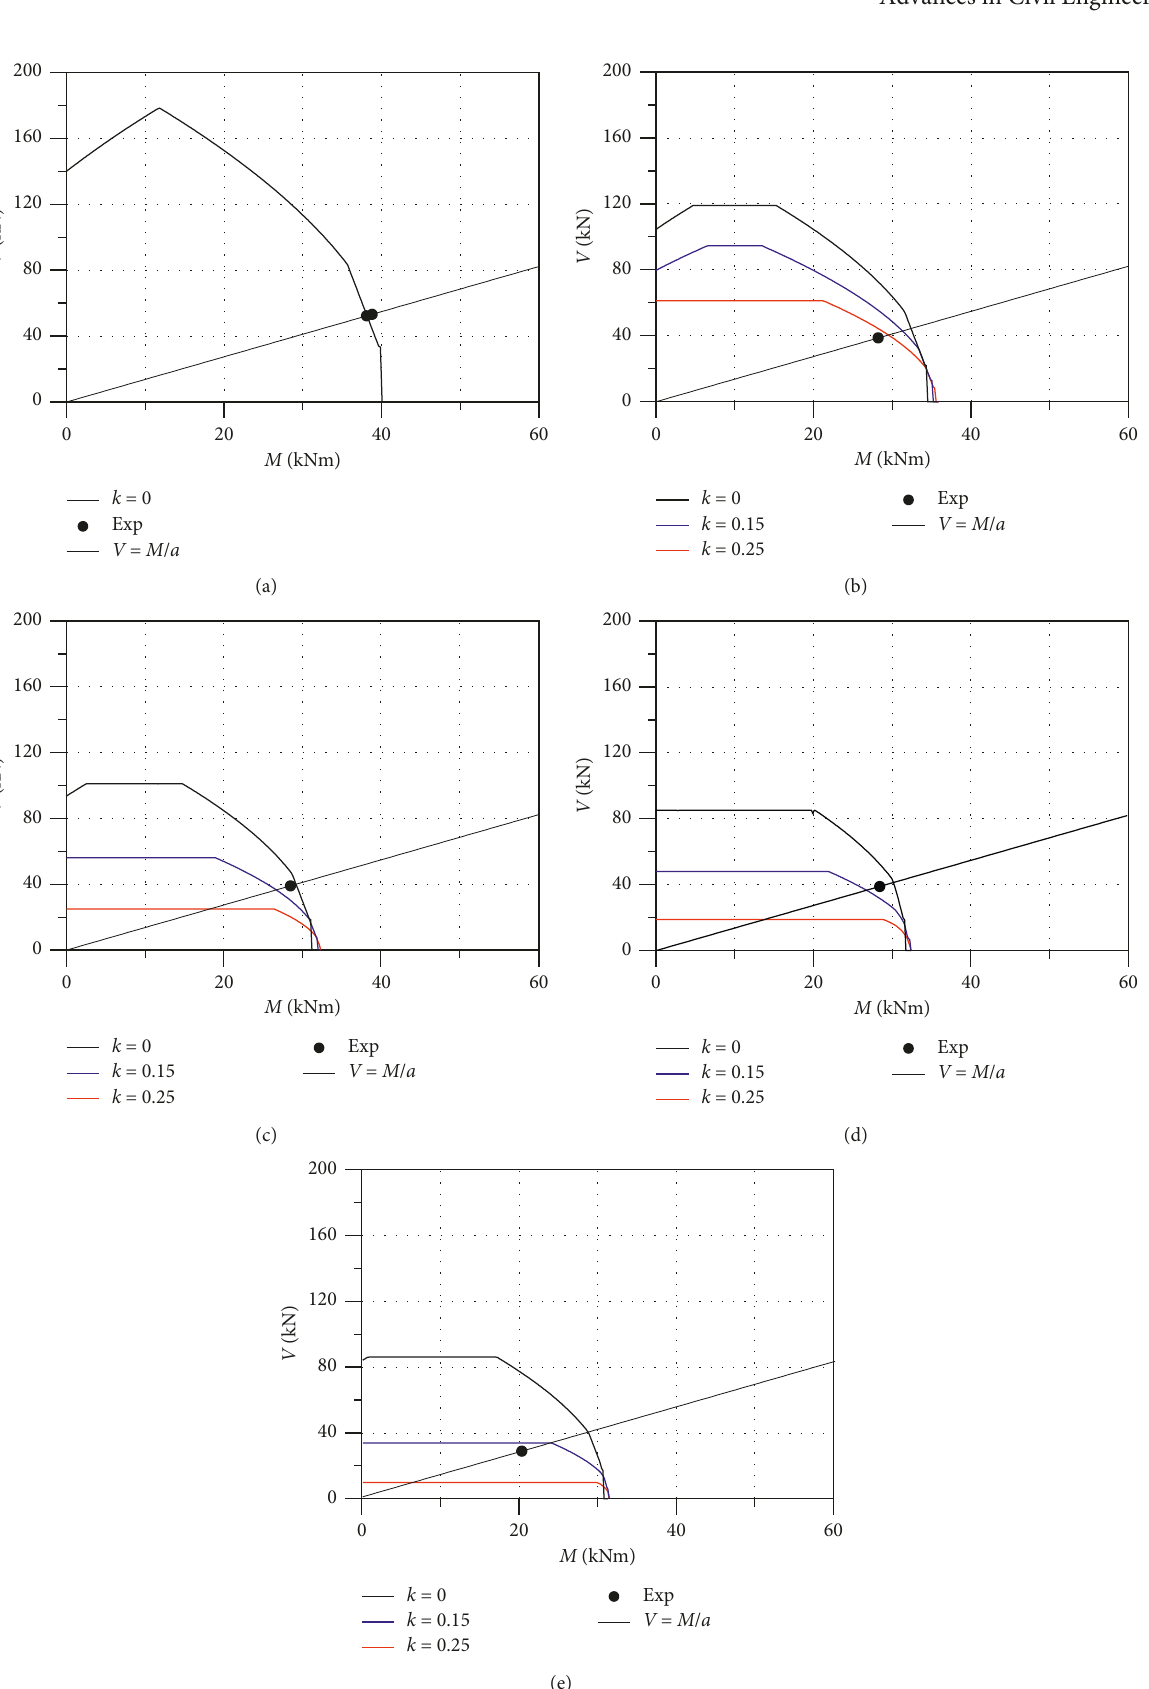
Figure 3: Interaction diagrams M - V for all specimens tested by Rodriguez et al. [6]. (a) 311-2, (b) 313, (c) 314, (d) 315, and (e)